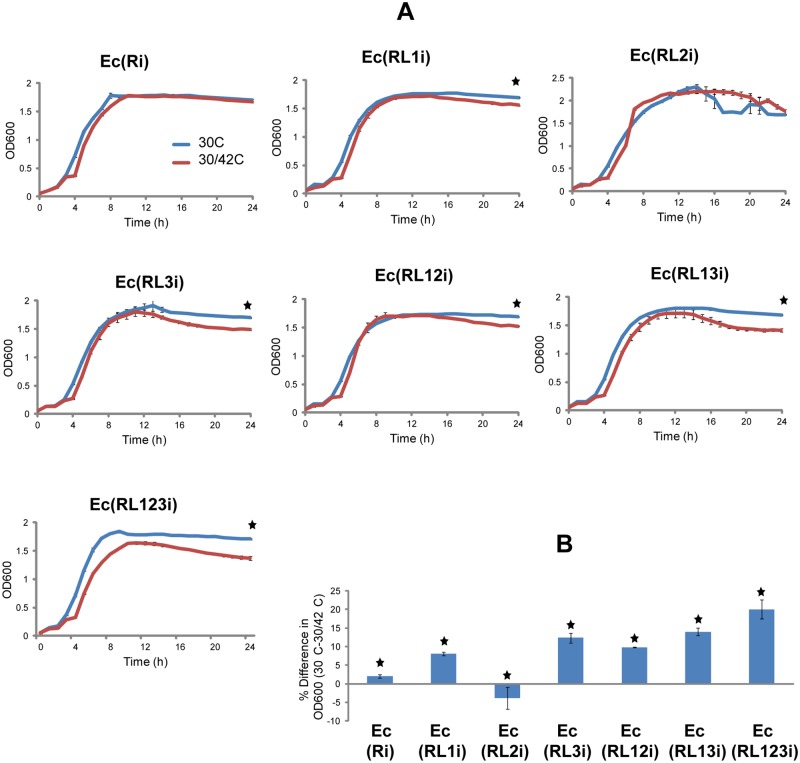
Lysis efficiency measured with the microplate reader.(A) Figure shows cell lysis efficiencies measured as absorbance over time with the microplate reader for strain Ec(Ri) and strains Ec(RL1i), Ec(RL2i), Ec(RL3i), Ec(RL12i), Ec(RL13i), and Ec(RL123i) harbouring integrated genetic circuits L1, L2, L3, L12, L13 and L123, respectively. Cells were grown at the restrictive conditions for the repressor for 24 hours (30°C) and at the restrictive/permissive conditions (restrictive conditions for 3 hours, followed by the permissive conditions for additional 21 hours (30/42°C)). Experiments were carried out in triplicate and the mean and standard error were calculated. T-tests were conducted to compare the differences between the absorbance at the restrictive (30°C) and restrictive/permissive conditions (30/42°C) at the end of measurement period for each analyzed strain. Stars show significant difference (p<0.05) between the absorbance at 30°C and 30/42°C for each strain. The differences were significant in all strains, except Ec(Ri) and Ec(RL2i). (B) Figure shows combinatorial effect of lysis genes on the degree of lysis calculated from the differences between the mean absorbances of cultures grown at 30°C and 30/42°C at the end of measurement period. T-tests were performed to compare the differences between strains Ec(RL123i) and other strains harbouring fewer lysis genes. Stars indicate significant differences (p<0.05) in the lysis efficiencies between Ec(RL123i) and other strains.